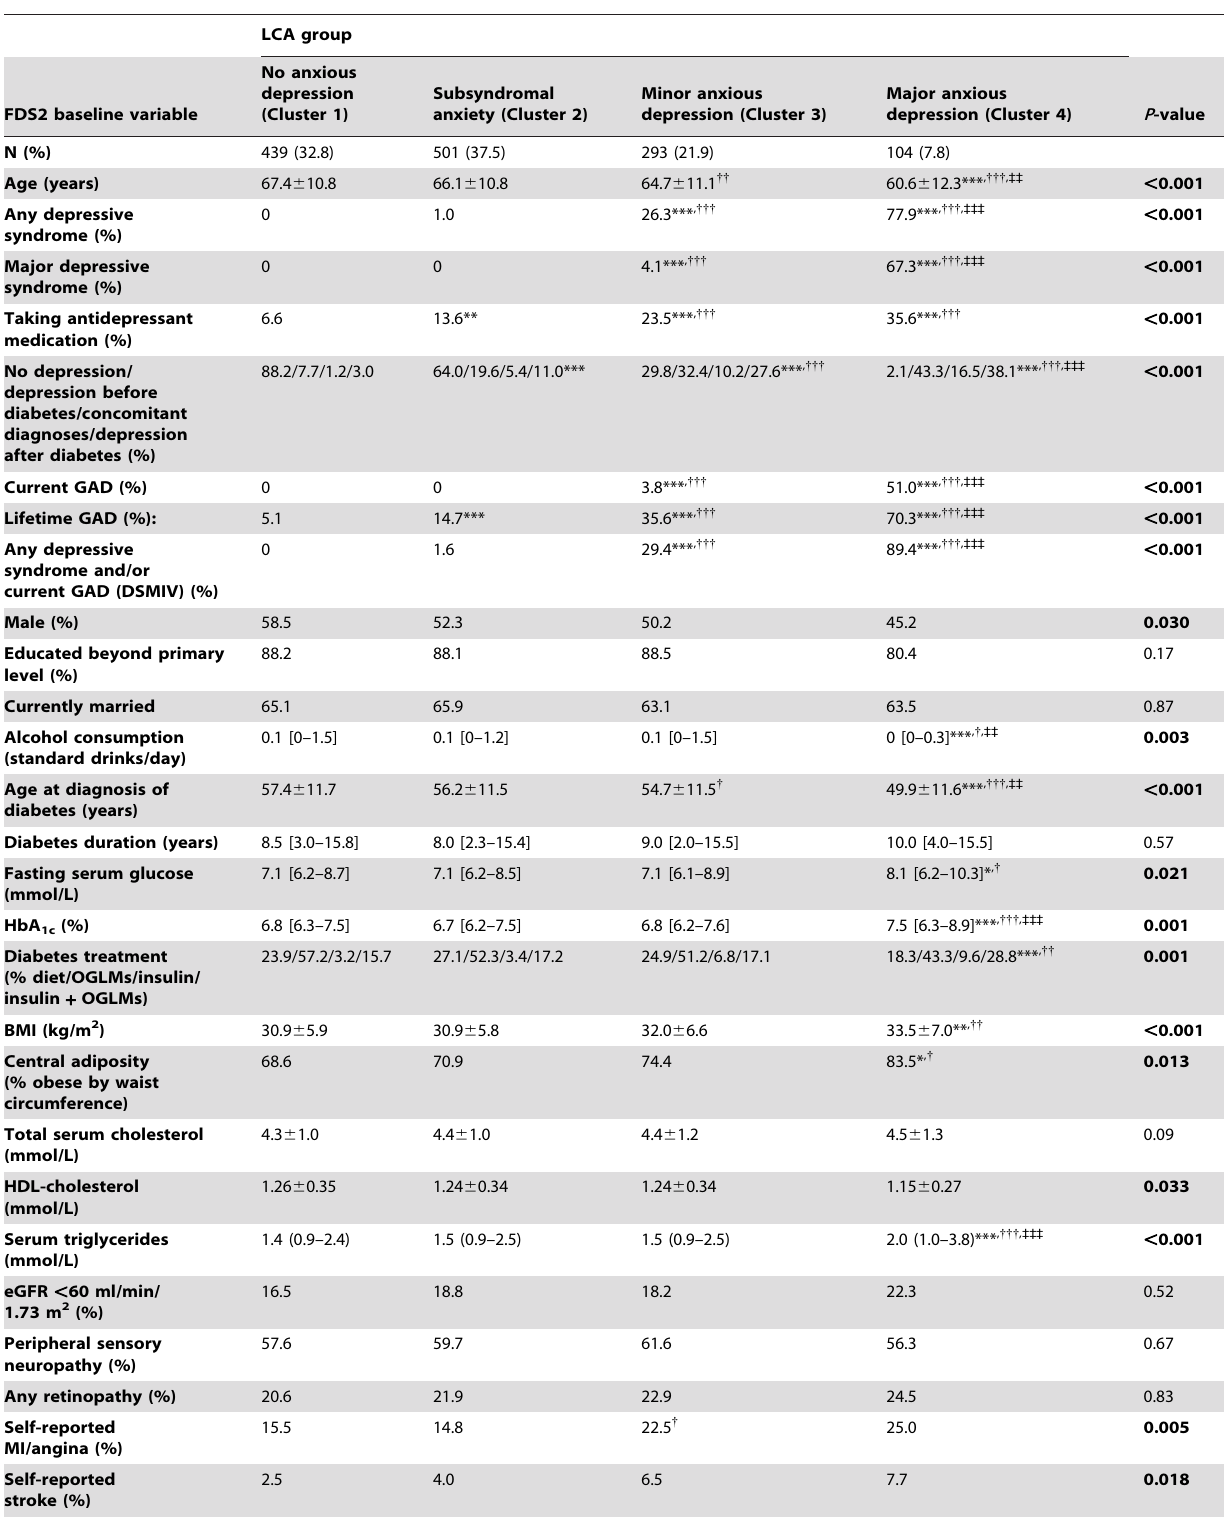
Table 4. FDS2 baseline associates of four LCA groups in participants with type-2 diabetes.